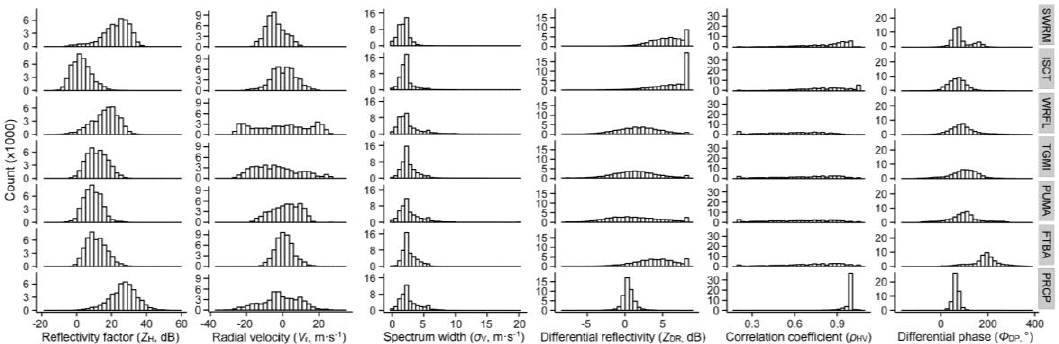
Figure 1. Array of histograms showing the distribution of values of six radar variables for seven types of scatterer.